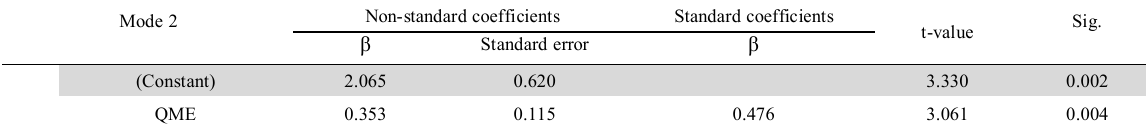
The results of the effects of QME on KI Mode 2 Non-standard coefficients Standard